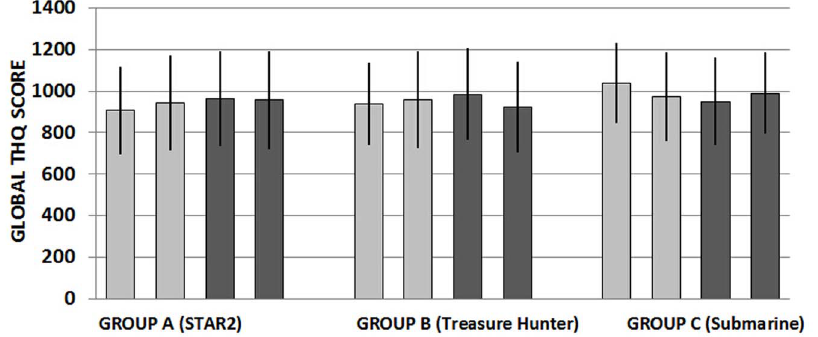
Figure 4. Global Tinnitus Handicap Questionnaire scores. Mean tinnitus handicap score ( 6 95% CI) at the primary assessment points (T0 and T1 – black bars) and at follow up visits T2 and T3 (grey bars). n=20 per group. Global score range in 0–2700.